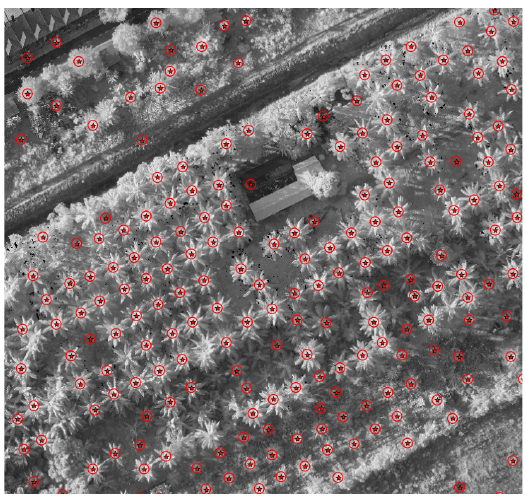
Figure 13: Object map of Image 01 with δ = 40 px